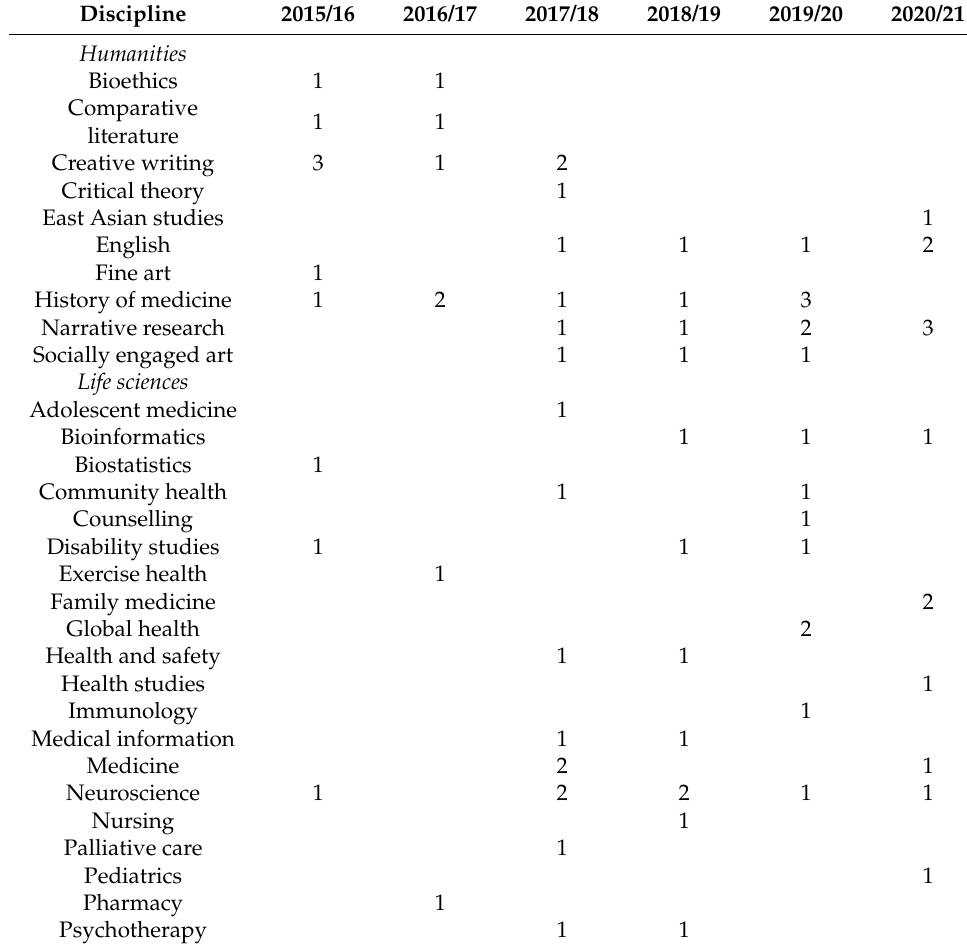
Table 1. HeNReG Participants by Discipline and by Academic Year for All Six Years the Academic Meeting Has Been Sponsored by the Department of